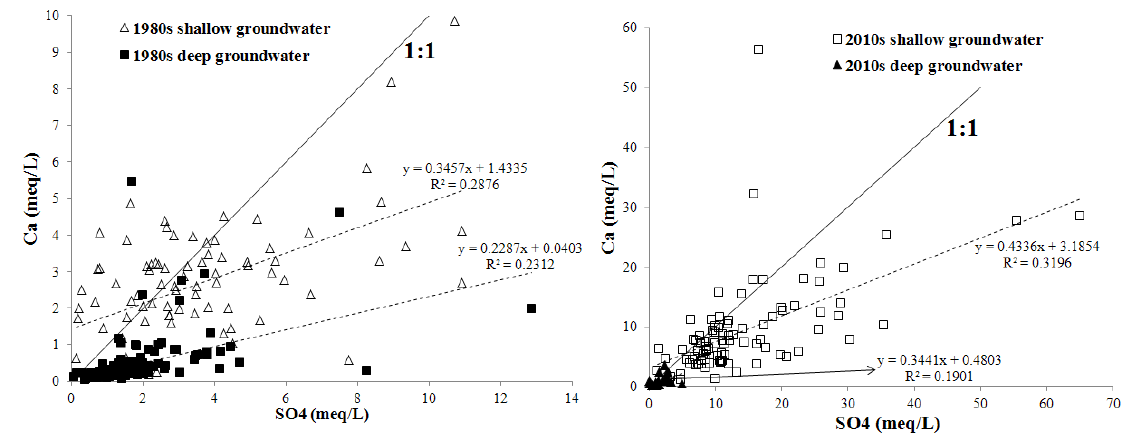
Figure 9. Scatter diagram of Ca 2+ vs. SO 42 − of groundwater samples in